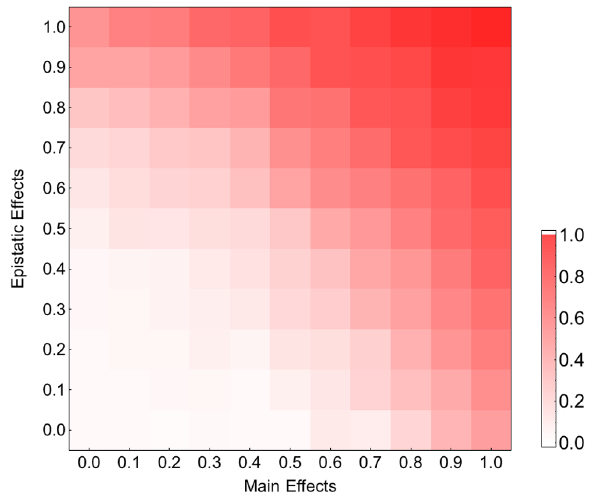
Figure 3. Contribution of the main and epistatic effects to the recombination effect on adaptation on the HIV-1 fitness landscape. The x and y axes show the values of the constants by which the elements of the main and epistatic effects, respectively, are multiplied in the hierarchical fitness landscape. The plot shows the logarithm (base 10) of the ratio of mean fitness of the recombining to that of the non-recombining populations at generation 100, averaged across 100 simulations. Parameters take values: N ~ 10 5 , r ~ 10 { 1 and u ~ 10 { 3 .